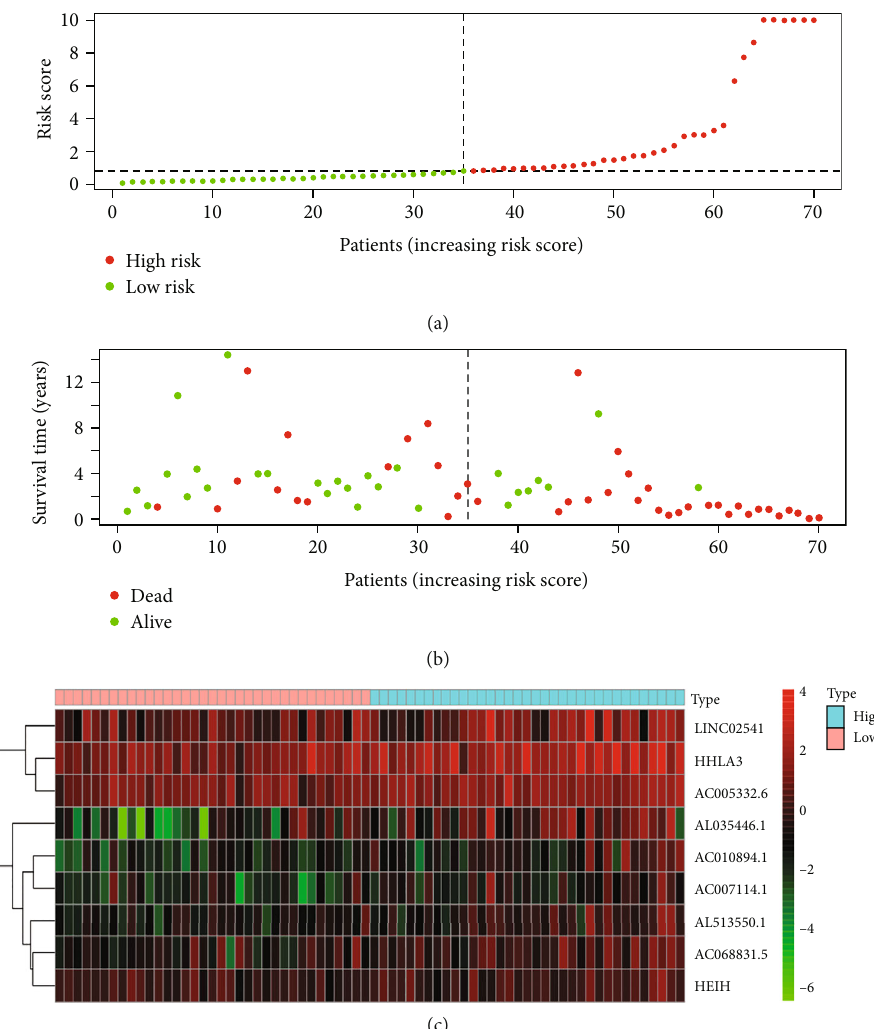
Figure 4: (a) The risk curves of OSCC patients. Abscissa: patients ’ risk scores ranked from low to high; ordinate: risk score. Red dots: high- risk group; green dots: low-risk group. (b) The risk scatter plots of OSCC patients. Ordinate: survival time. Red dots: dead patients; green dots: alive patients. (c) The risk heat maps of nine m7G-related prognostic lncRNAs of OSCC patients. Red squares: high-expression lncRNAs; green squares: low-expression